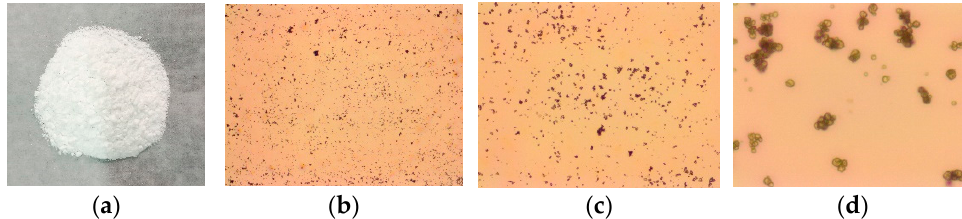
Figure 1. Microscopic morphology of CSNPs. The first from the left are CSNPs ( a ), followed by 40× ( b ), 100× ( c ), 400× ( d ).